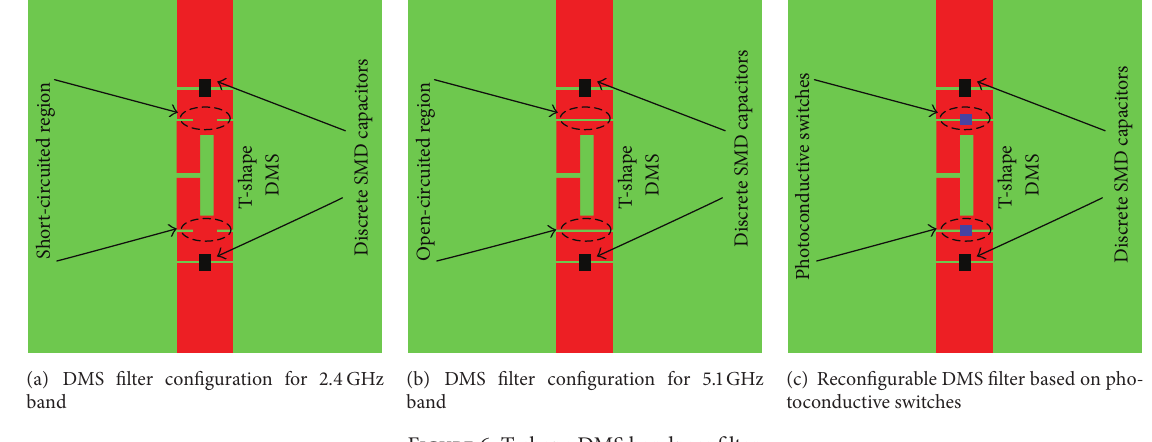
Figure 6: T-shape DMS bandpass filter.